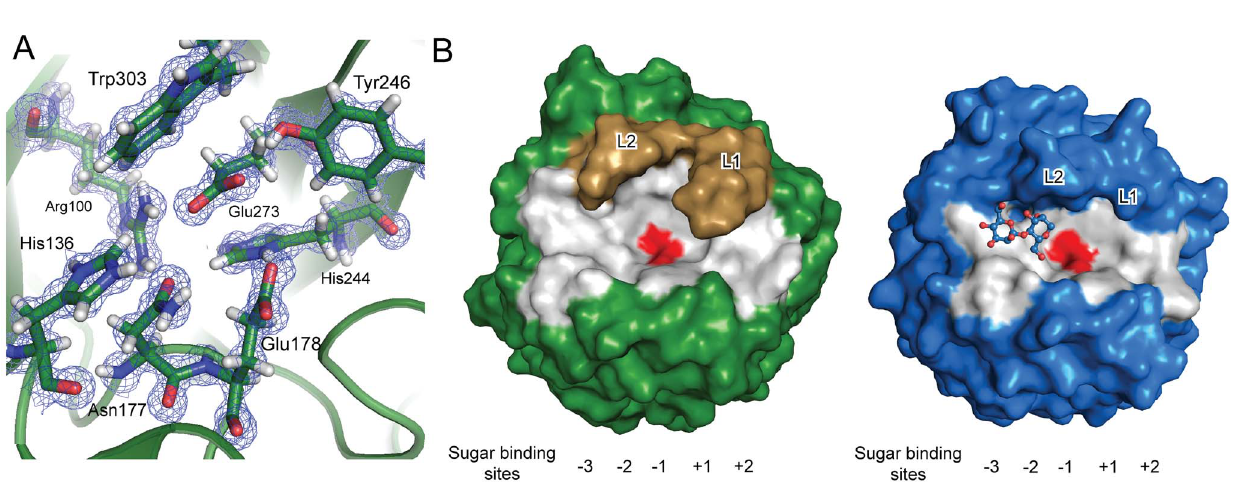
Figure 4. Atomic resolution structure of SACTE_2347. A, 2Fo-Fc electron density map of eight conserved residues in the GH5 family, contoured at 1.3 s . Hydrogen atoms were included in the refinement of the high-resolution data. B, Comparison of the active site channels of SACTE_2347 (green) and TfManA (blue). Residues that form the surface of the channel are highlighted in gray, and the positions of loops L1 and L2 are indicated. Positions of the catalytic residues (Glu178 and Glu273 in SACTE_2347_34kDa) are shown in red. Mannobiose observed in the 2 3 and 2 2 subsites of the TfManA structure is shown as ball and sticks.